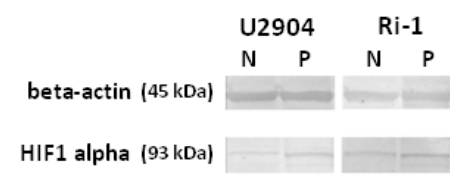
Figure 2. Immunocytochemical ( A ) and Western blot analysis ( B ) of the hypoxia-inducible factor 1-alpha (HIF1 α ) expression in lymphoma cell lines U2904 and Ri-1 under normoxia (21% O 2 ) and physioxia (5% O 2 ). Magnification × 200.